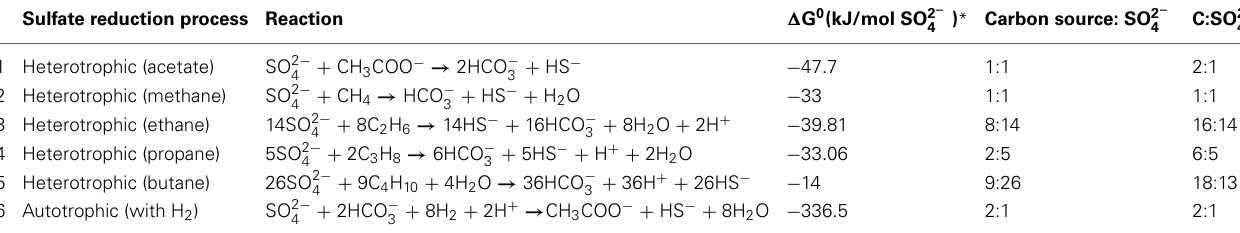
Table 6 | Gibbs free energy of the anaerobic oxidation of acetate, methane, and alkanes using sulfate as an electron acceptor (conditions shown are at standard temperature and pressure).